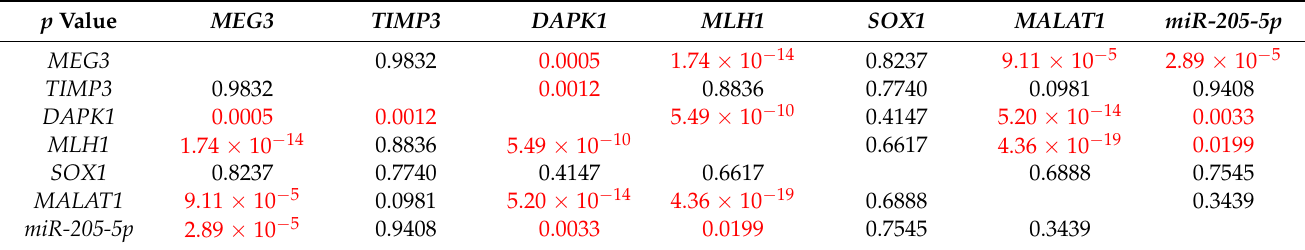
Table 2. Statistical correlation between the expressions of the tested